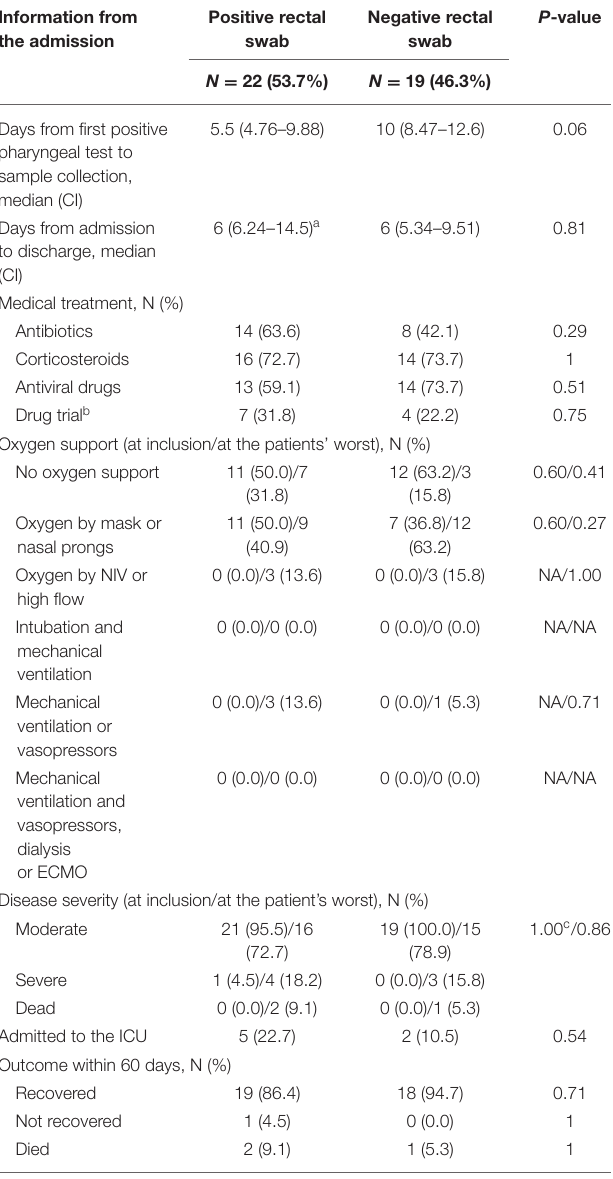
TABLE 3 | Information from admission of COVID-19 adult patients with positive and negative rectal swabs, respectively. Information from the admission